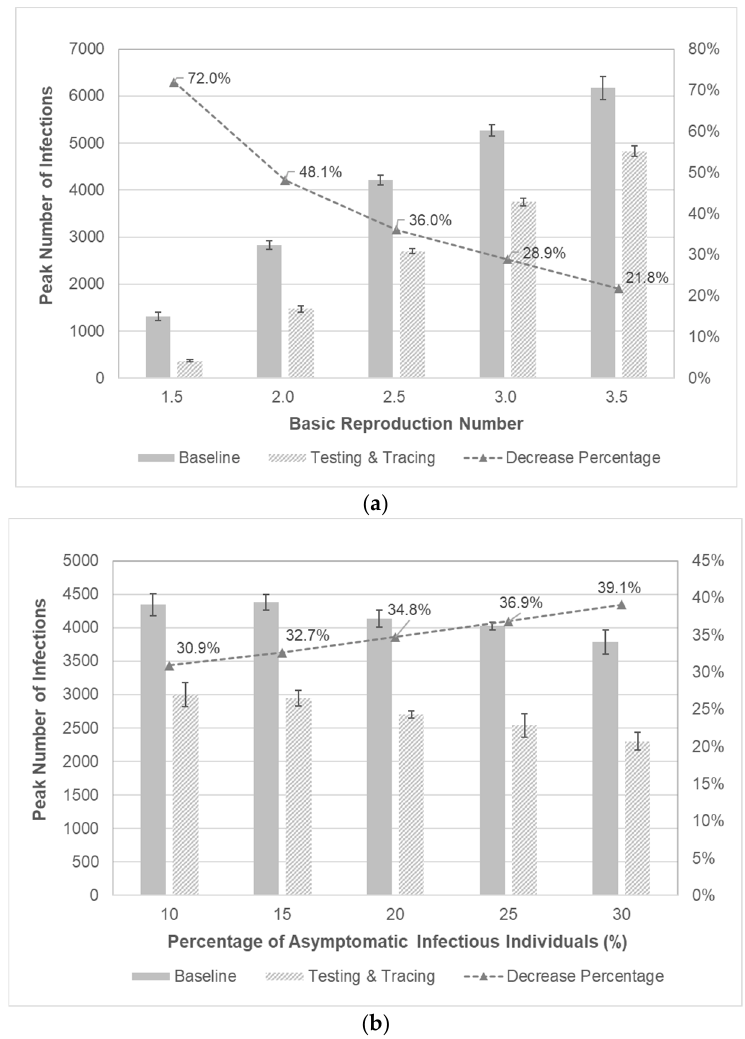
Figure 8. Sensitivity analysis with respect to epidemiological parameters. ( a ) Comparison of peak number of infections with respect to R 0 . The 95% confidence intervals are represented as bar graphs at each point. ( b ) Comparison of peak number of infections with respect to the percentage of asymptomatic infectious individuals. The 95% confidence intervals are represented as bar graphs at each point.